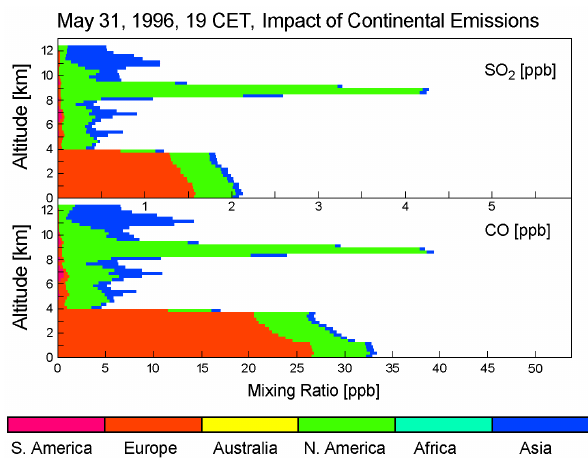
Fig. 6. Vertical distribution of FLEXPART SO 2 and CO emis- sion tracers from the different source continents above Garmisch- Partenkirchen, simulated for the time of the lidar measurement on 31 May 1996 shown in Fig. 1 (twenty-day simulation). Please, note that the numbers in the mixing-ratio scales are just rounded to the next integer